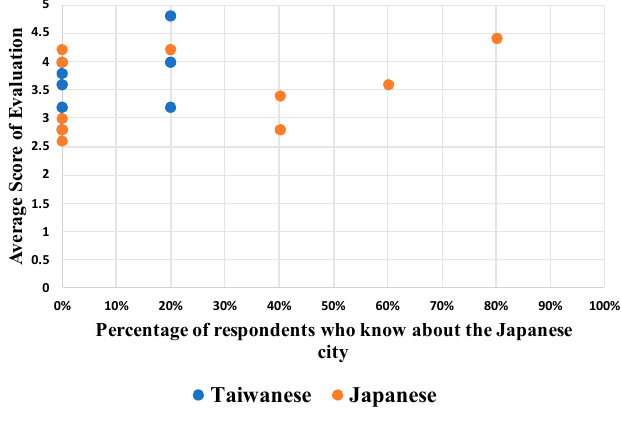
Figure 6. Evaluation result: Category 1.